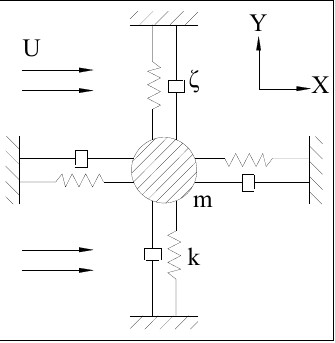
Figure 2. Vortex-induced vibration model of cylindrical vibrator.